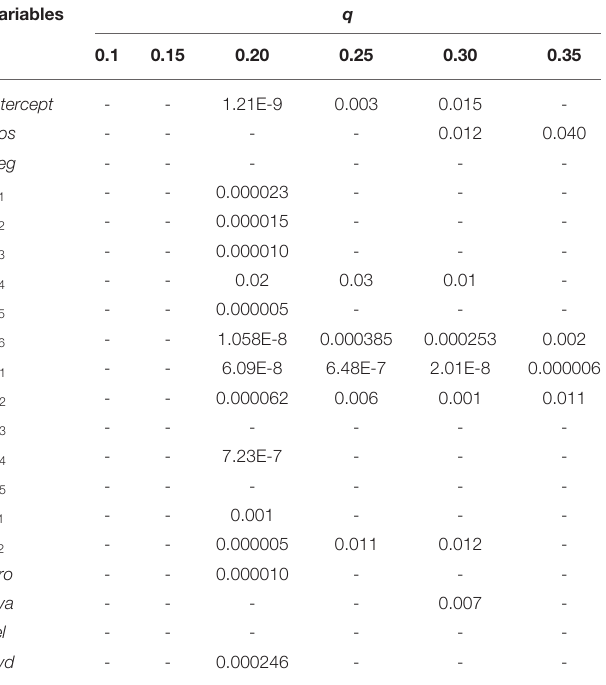
TABLE 6 | Quantile regression coefficient significance table for each quantile (quantile 0.1 ∼ 0.35). Variables